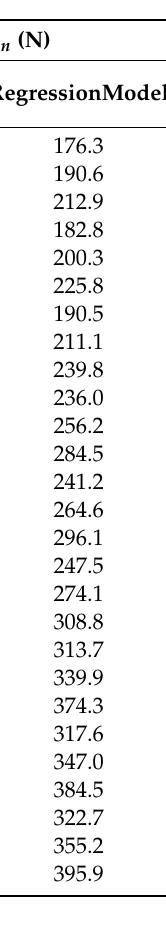
Table 5. Main machining force comparison between the simulated and statistical